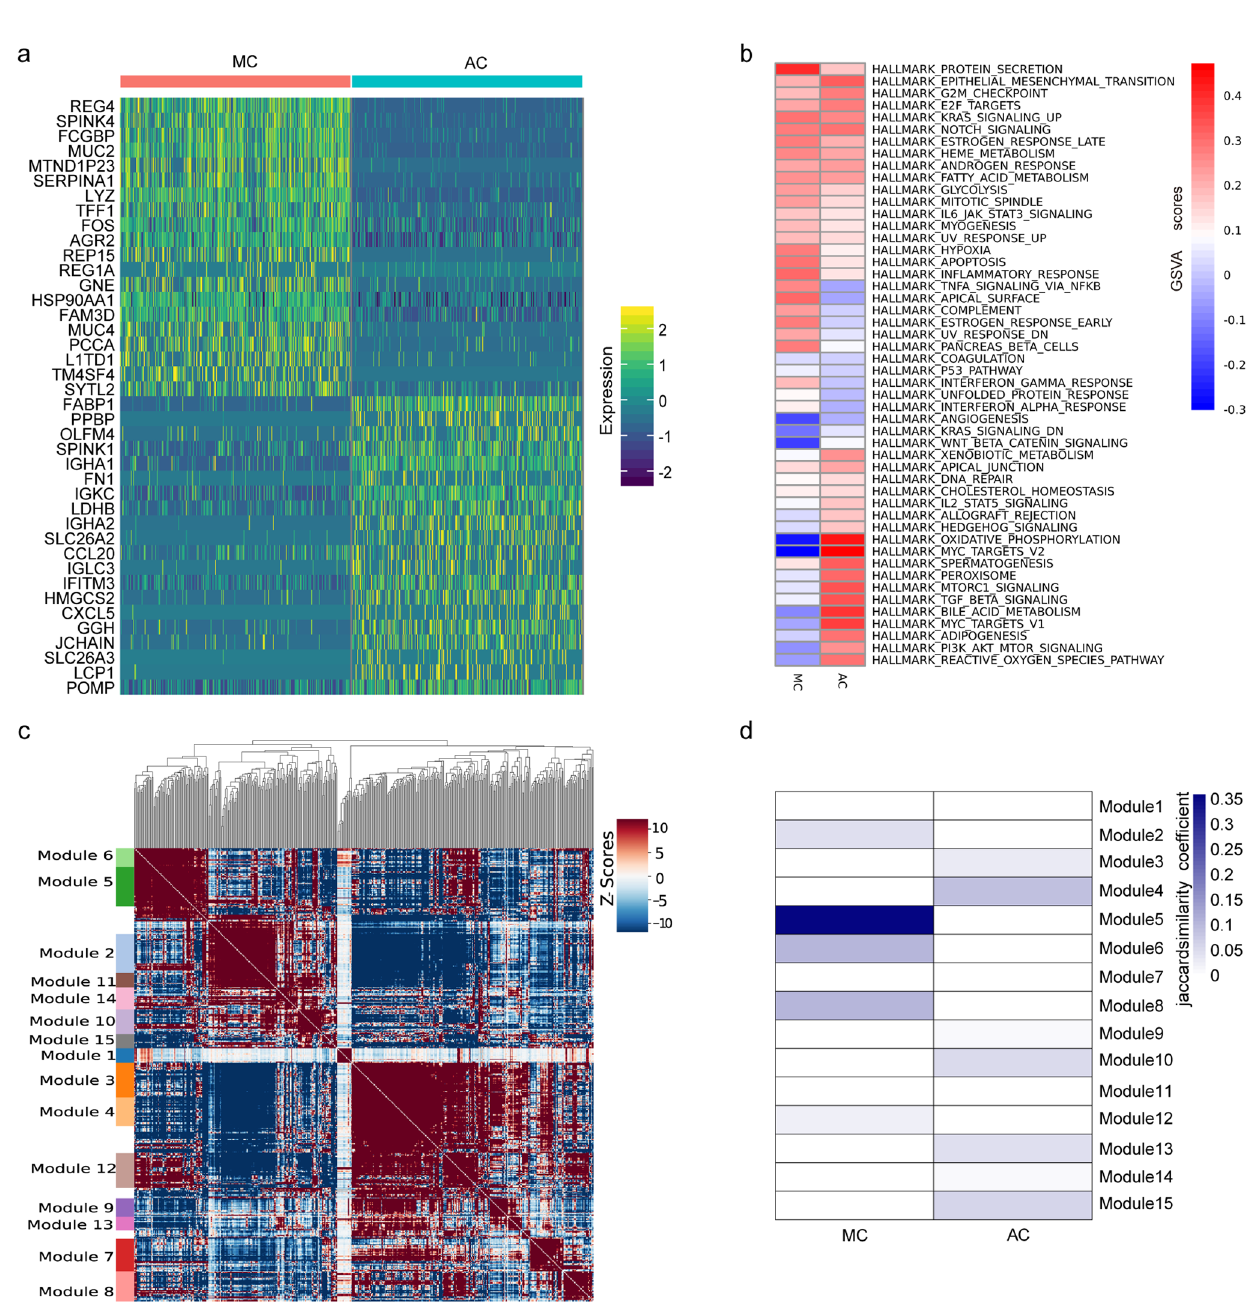
Fig. 4 Speci fi c molecular characteristics of MC cancer cells. a Top 20 DEGs between MC and AC. Colour key from blue to yellow represents the scaled expression levels of DEGs from low to high. b Heatmap of GSVA of the 50 hallmark gene sets in the MSigDB database between the two groups. Colour key from blue to red represents the GSVA scores from low to high. c Heatmap of gene correlations, with colour shades representing the Z score values. The notes on the left indicate the gene sets. d Heatmap of similarity between cell types and gene sets, with colour shades representing the Jaccard similarity coef fi cient